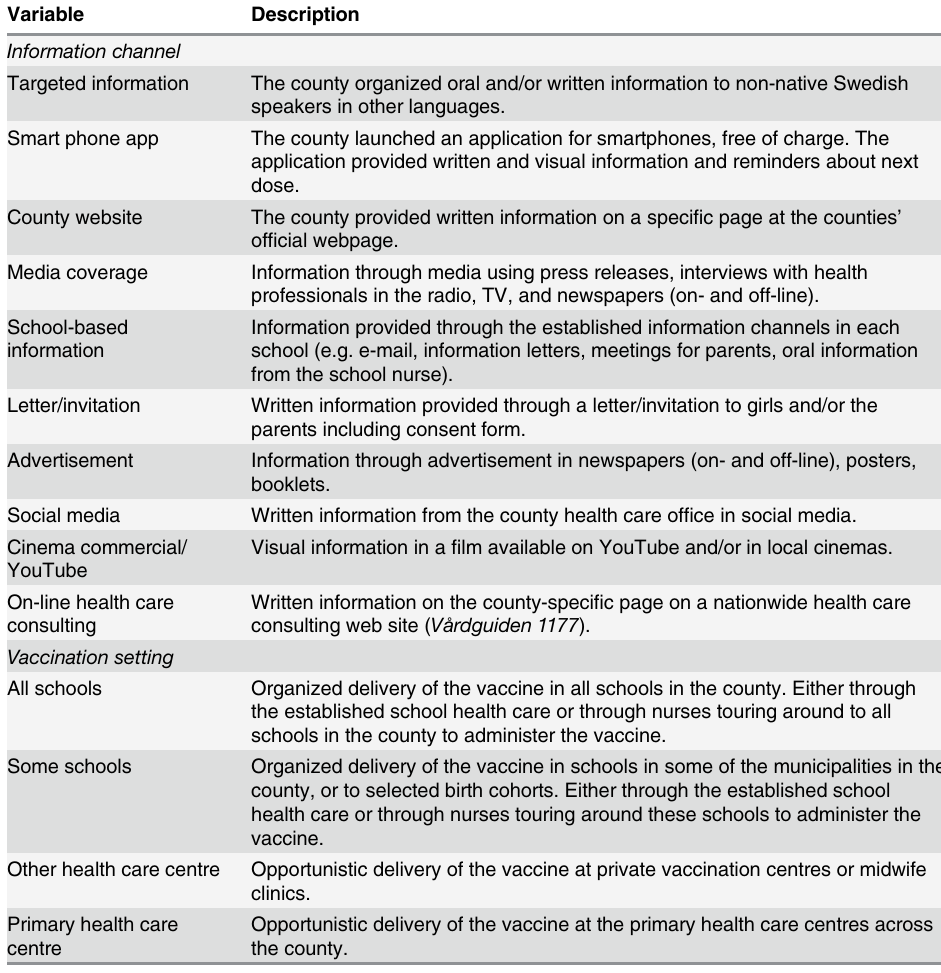
Table 1. Description of information channels and vaccination settings used among counties to imple- ment catch-up vaccination of girls born 1993 – 1998, Sweden 2012 –